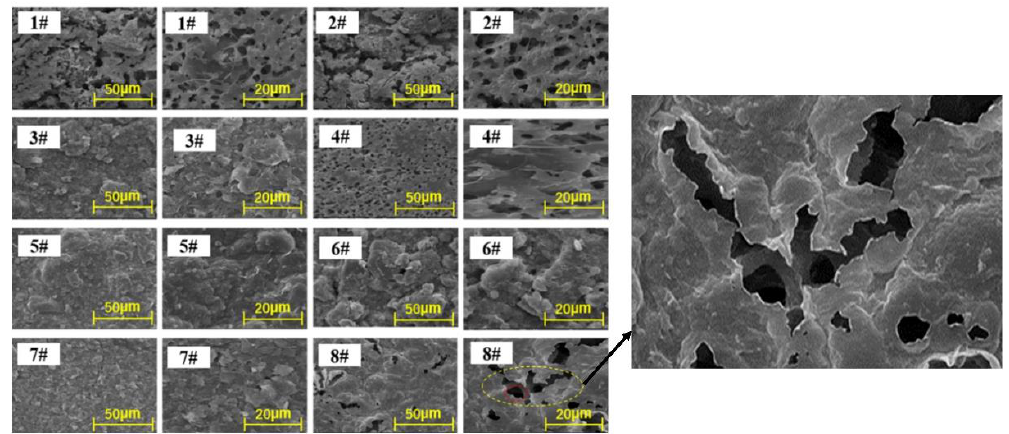
Figure 10. The microscopic pore structure of the surface of the mud cake.